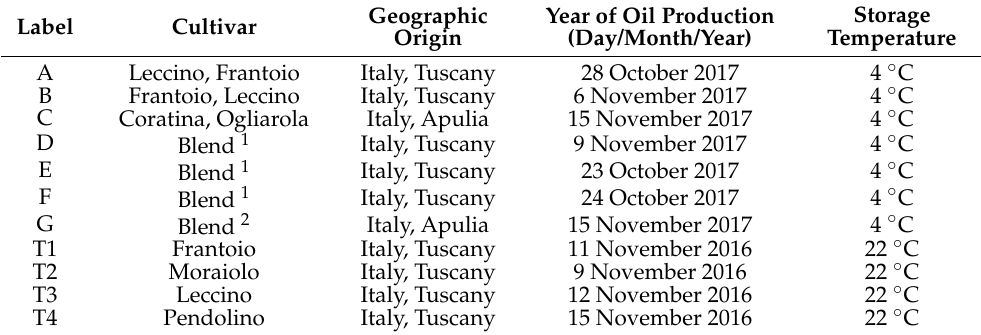
Table 1. EVOO samples used in the present work. Cultivar (with prevalence of one or two cultivars), or blend of different cultivars are indicated. Labels of each sample, geographic origin, day of oil production, and temperature of storage are also